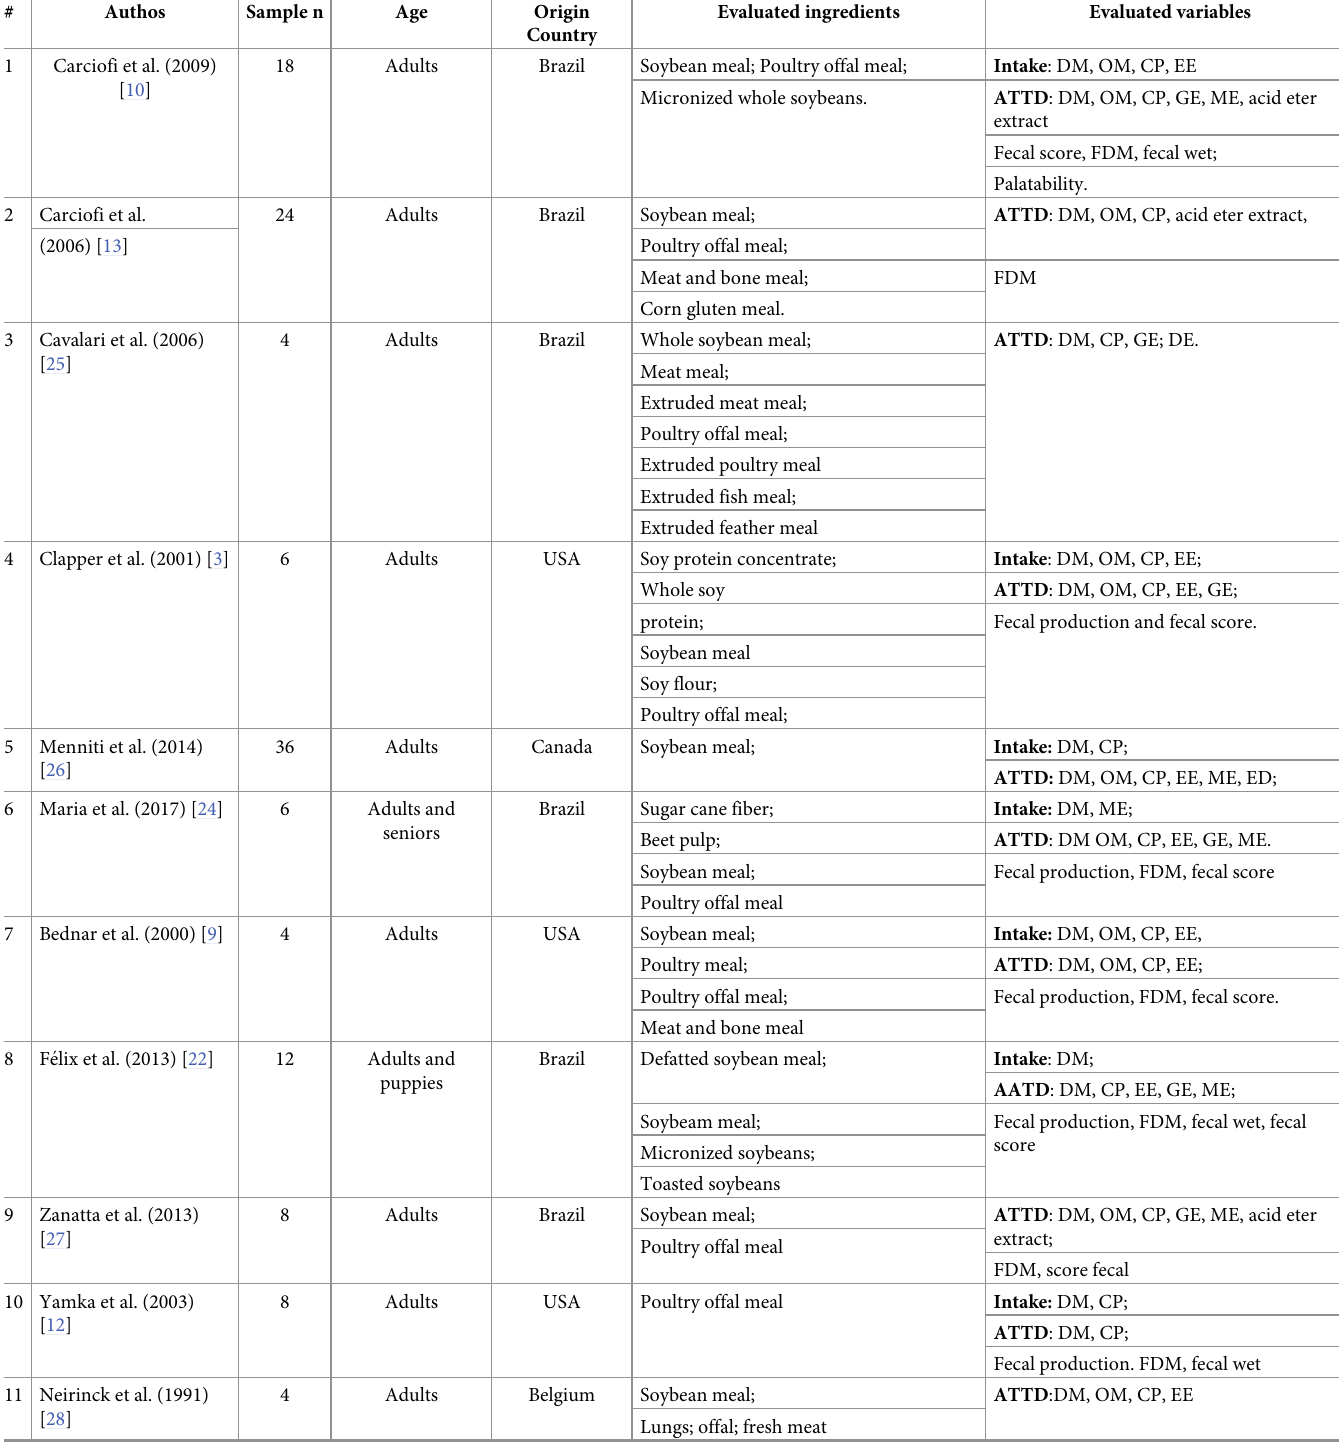
Table 2. Database of intake levels, nutrients digestibilty coefficients and fecal characteristic of dog protein ingredients according selected articles for systematic